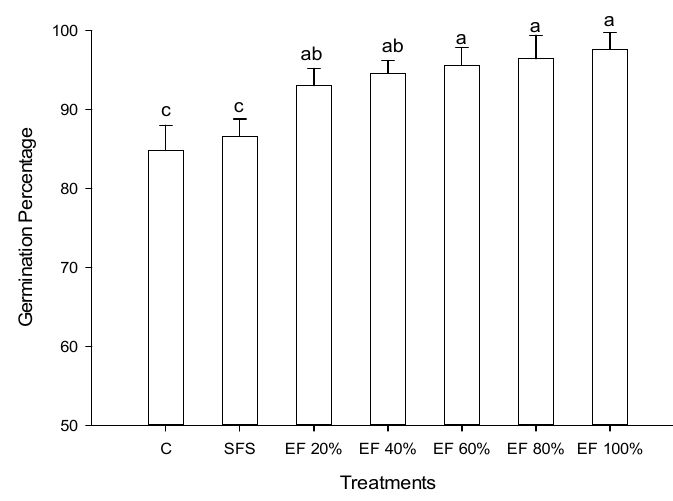
Figure 8. Effect of LSEs on germination percentage of cherry tomato seeds.